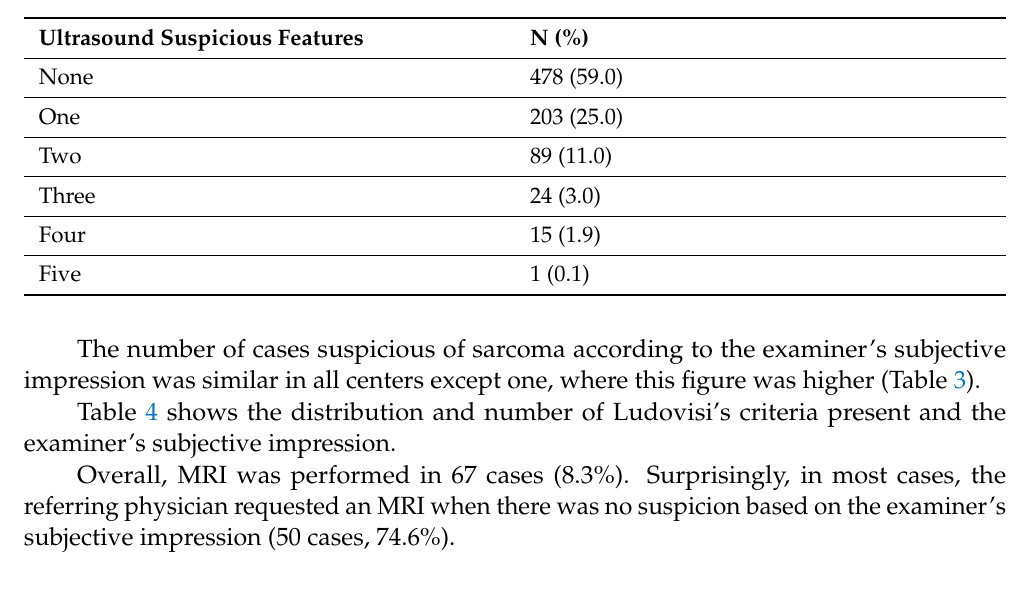
Table 2. Number of suspicious ultrasound features present in myomas in this